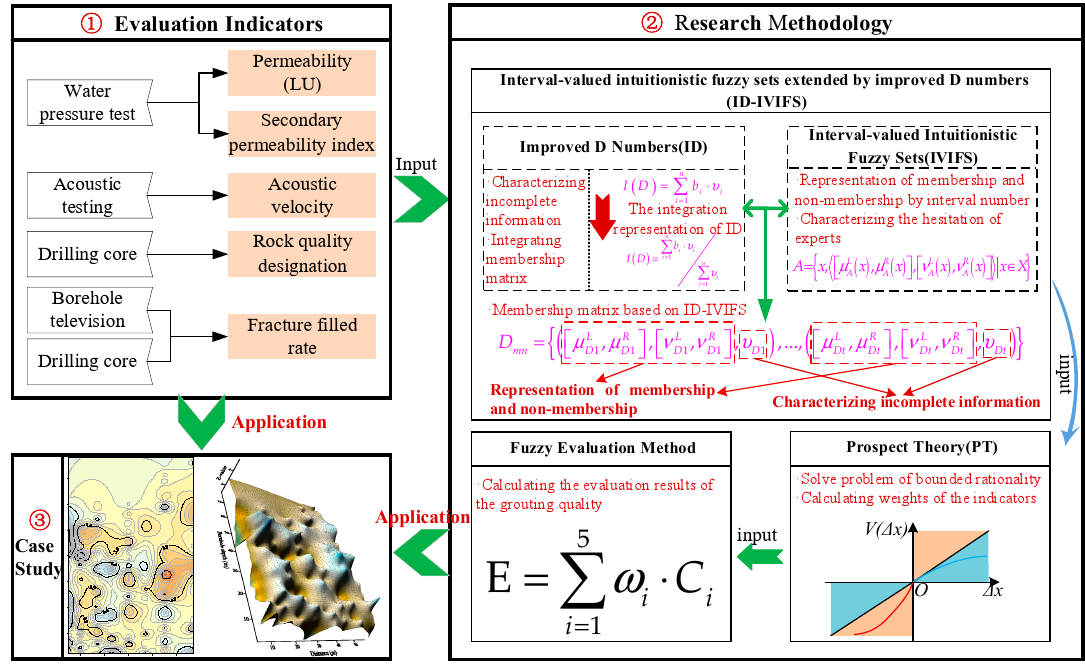
Figure 1. Research Figure 1. Research framework.